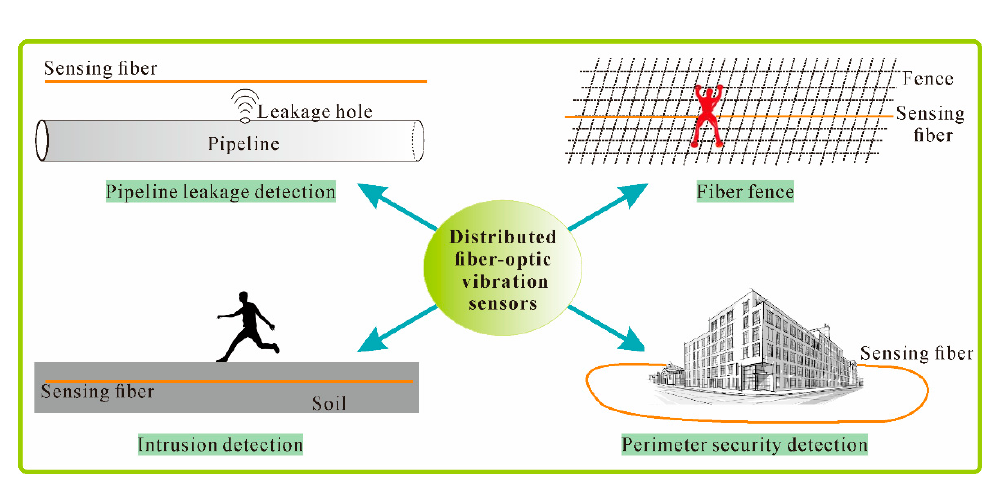
Figure 17. Several typical applications of distributed fiber-optic vibration sensors.